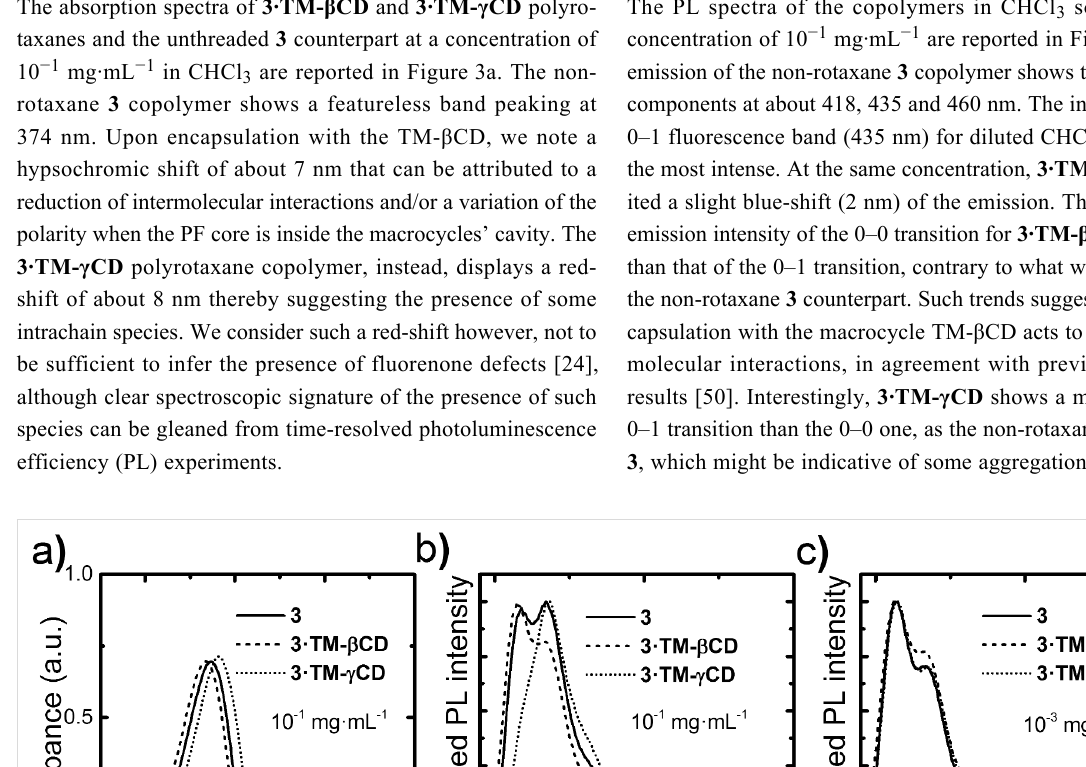
Figure 2: DSC traces on second heating scan of 3 , 3·TM- β CD and 3·TM- γ CD compounds.